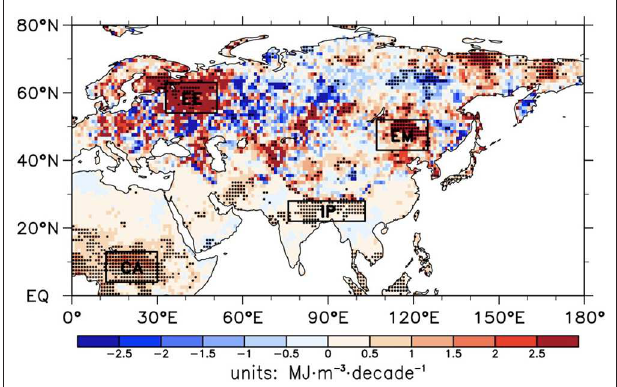
FIGURE 1 | Spatial distribution of linear trend of winter soil enthalpy from 1979 to 2010, and dotted area is significant ( p < 0.05).